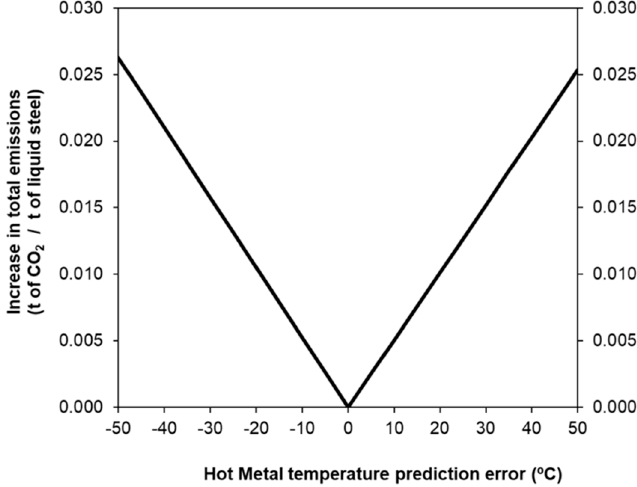
Figure 4. Effect of hot metal temperature prediction error on total carbon emissions according to [17] .